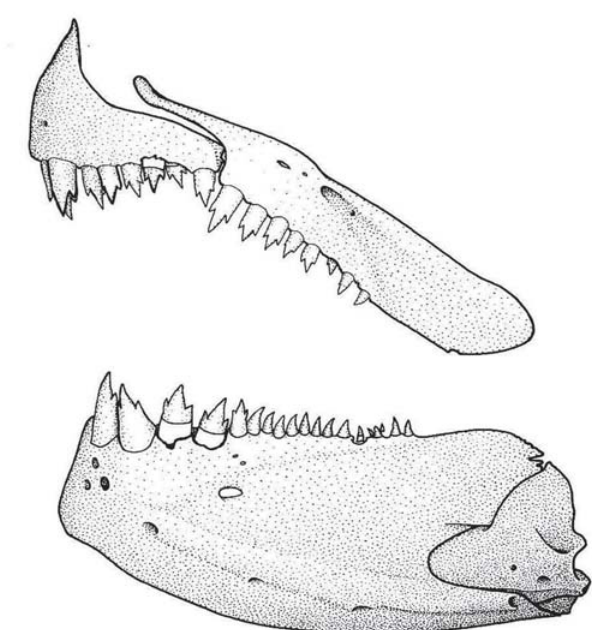
Fig. 69. Mimagoniates sylvicola , adult male, USNM 276557, 29.3 mm SL; jaws and dentition of adult male, lateral view, right side, anterior at left. Modified from Menezes & Weitzman